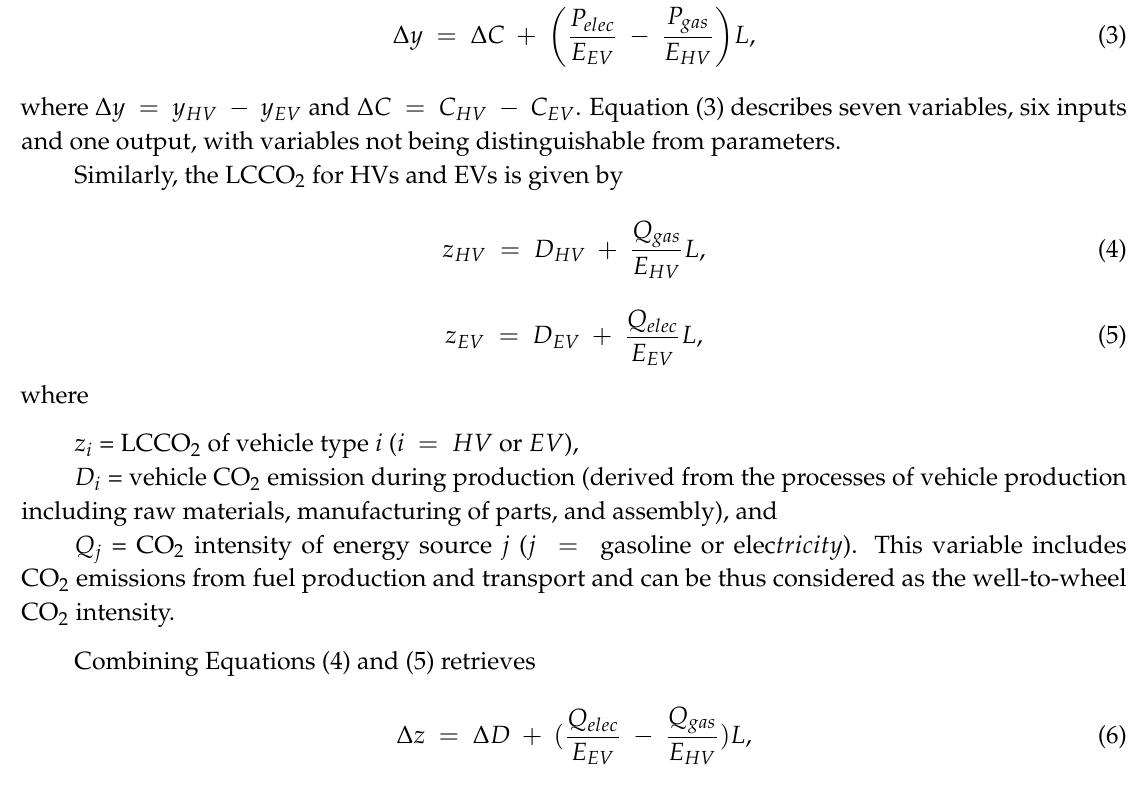
Table 1. Ranges of variables for LCC analysis.